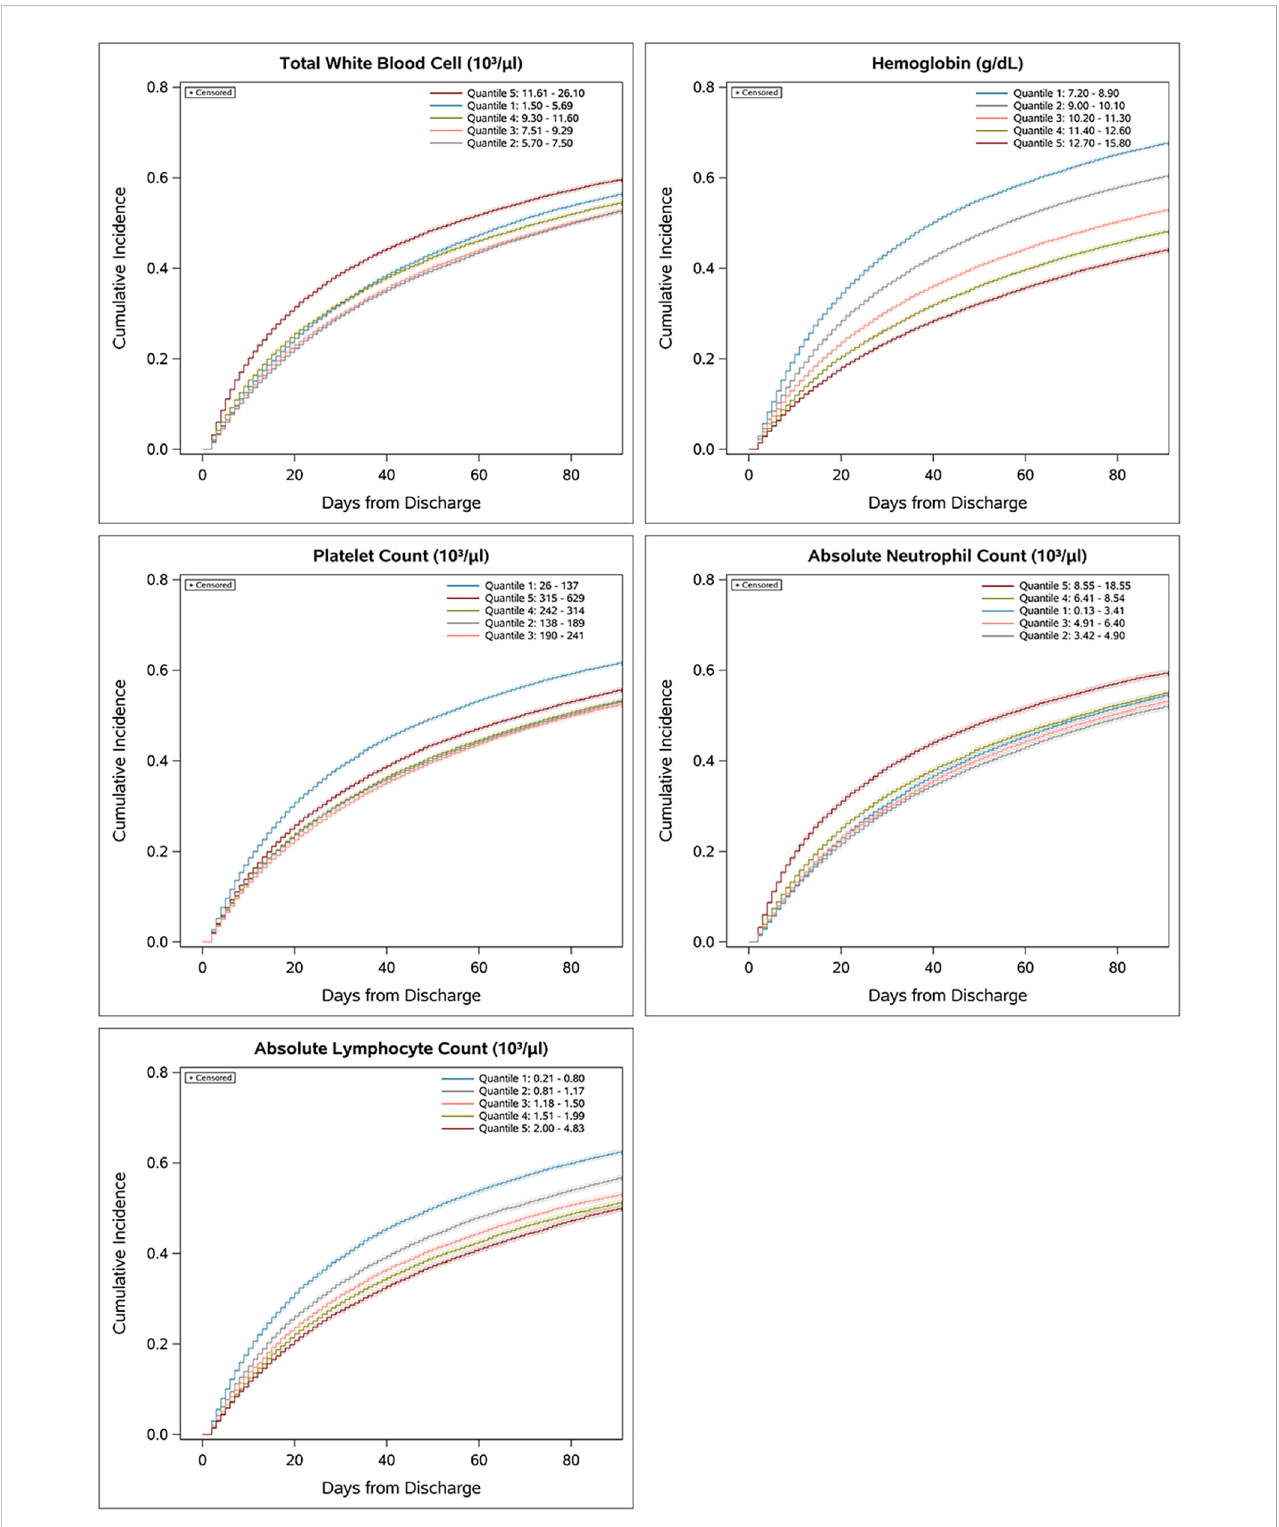
FIGURE 3 Association of individual CBCD parameters and cumulative incidence of 90-day mortality or rehospitalization. Univariate Kaplan-Meier failure plots showing cumulative incidence of the primary outcome by